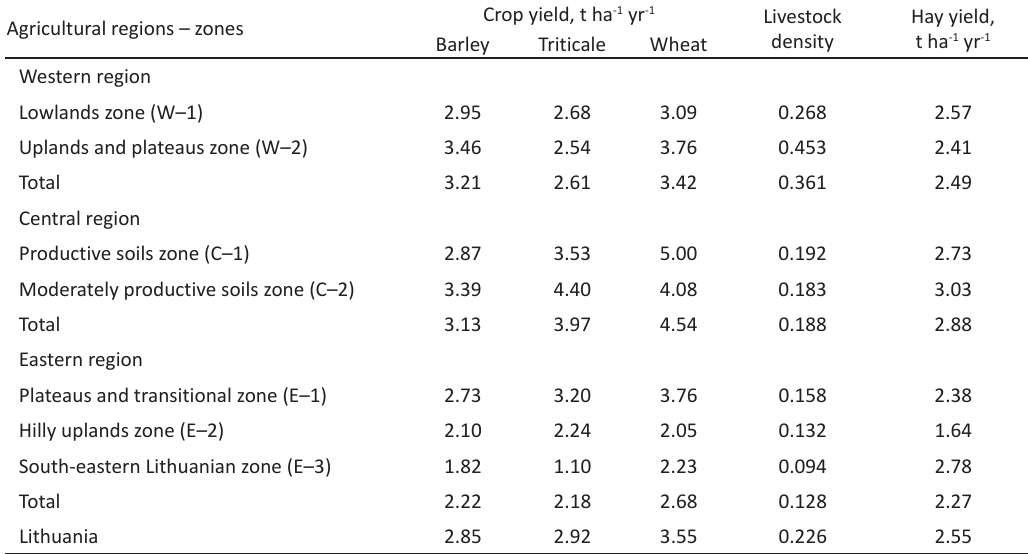
Table 3. Agricultural production at regional and national level 2014–2016 Agricultural regions –